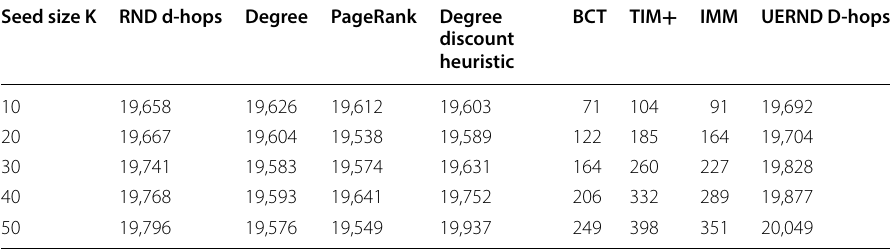
Table 3 The running time of our algorithm under the IC model on Nethept data for K